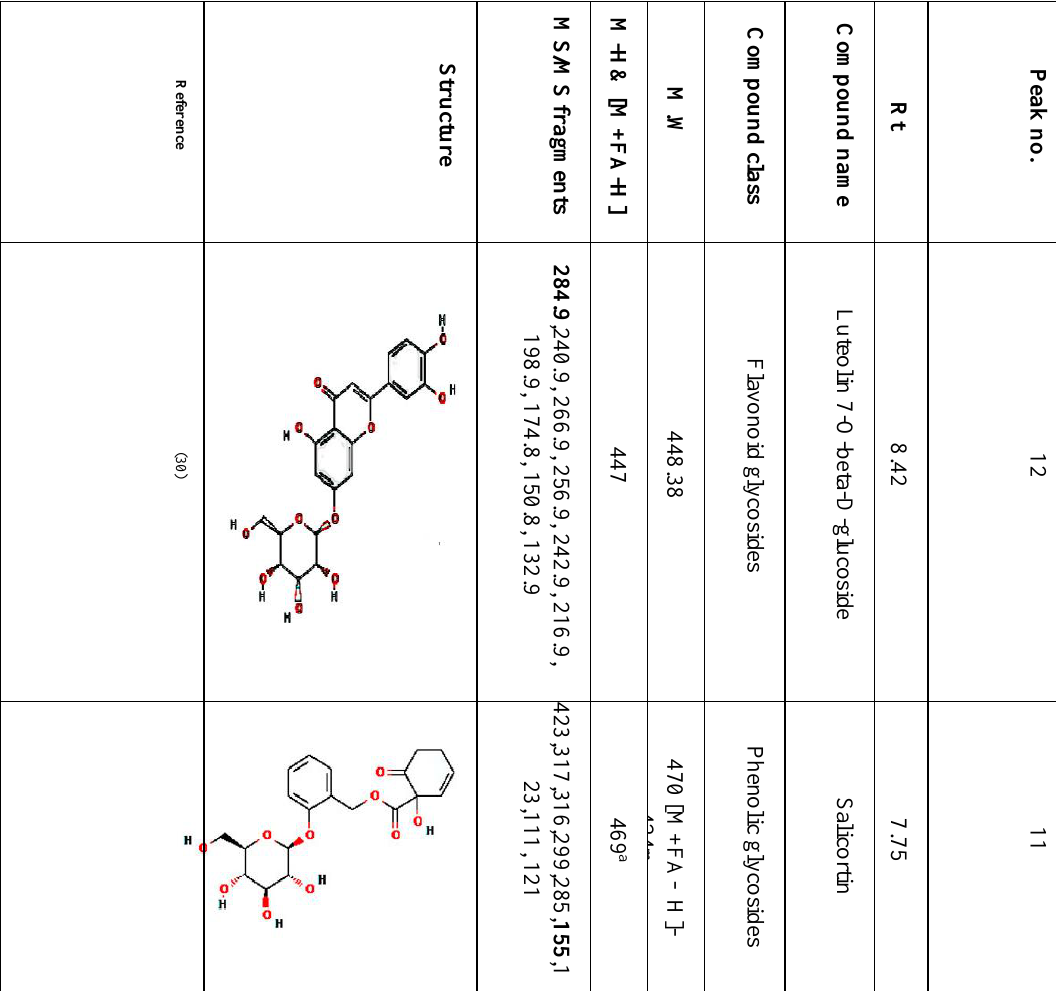
Table 5 .UPLC-ESI-MS/MS of B.B fraction.